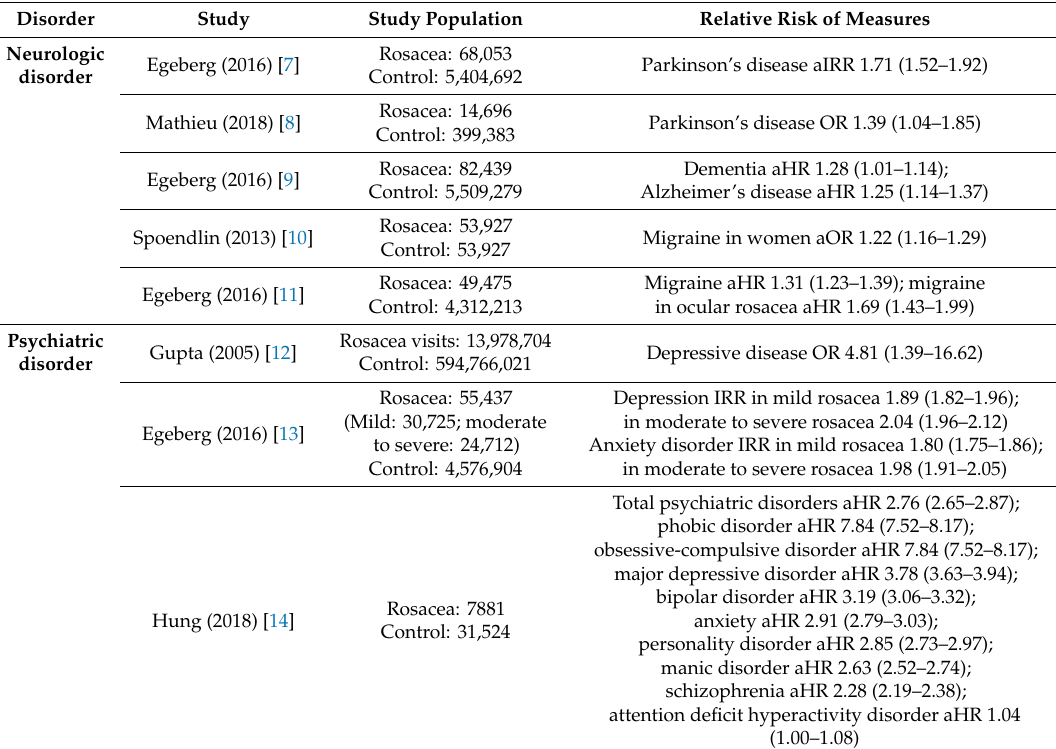
Table 1. Summary of recent (2000–2020) population-based cohort studies investigating the risk of psychiatric and neurologic disorders in patients with